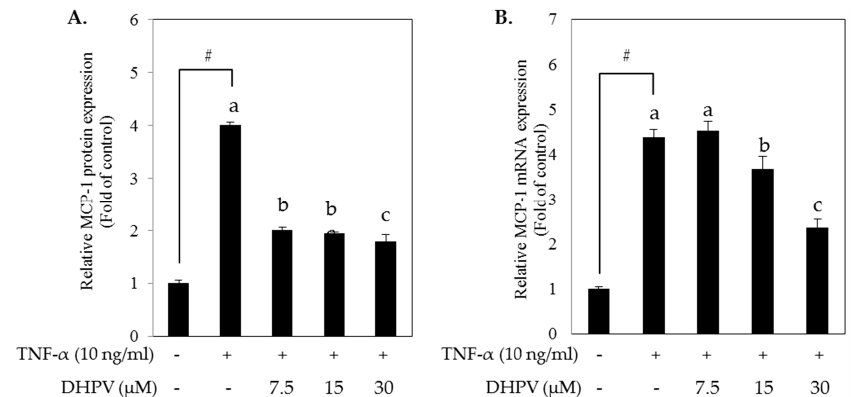
Figure 4. Effect of DHPV on MCP-1 expression in TNF- α -stimulated HUVECs. ( A ) Preventive effect of DHPV on TNF- α -stimulated MCP-1 protein secretion as assessed by ELISA; ( B ) MCP-1 mRNA expression was analyzed by RT-qPCR. Data are expressed as means ± SD ( n = 4). # p < 0.05